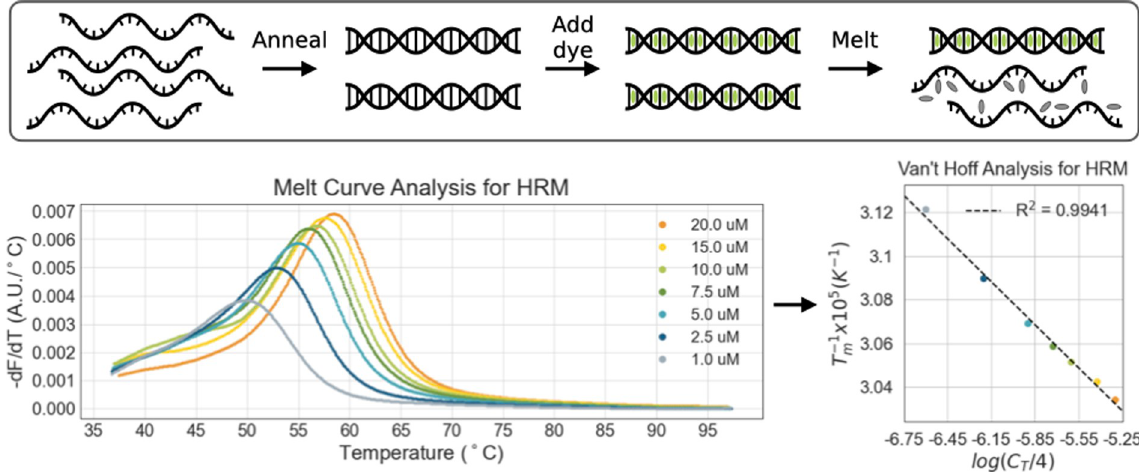
Fig 1. High-Resolution Melting (HRM) pipeline for determining duplex stability. Peak change in fluorescence (dF/dT) indicates melting temperature. Thermodynamic parameters are derived from Van’t Hoff analysis on HRM data. Since all sequences are non-self-complementary, 1/T m is plotted against ln(C T